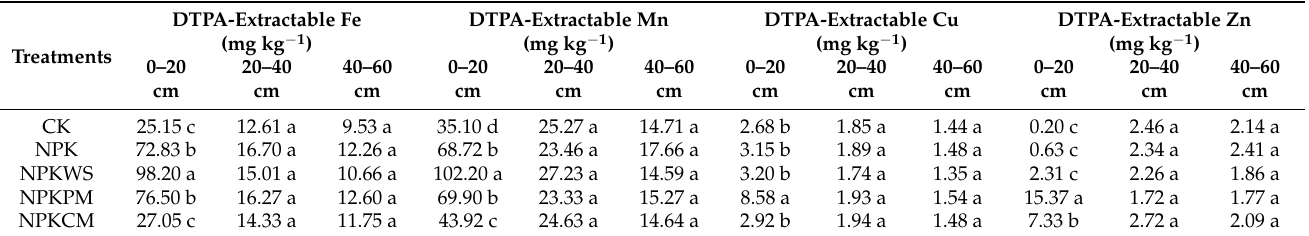
Table 3. Soil micronutrients (DTPA-extractable Fe, Mn, Cu and Zn) in the 0–20 cm, 20–40 cm and 40–60 cm depths after 32 years of fertilization in each treatment. CK: no fertilization; NPK: chemical fertilizers; NPKWS: NPK plus wheat straw; NPKPM: NPK plus pig manure; NPKCM: NPK plus cattle manure.